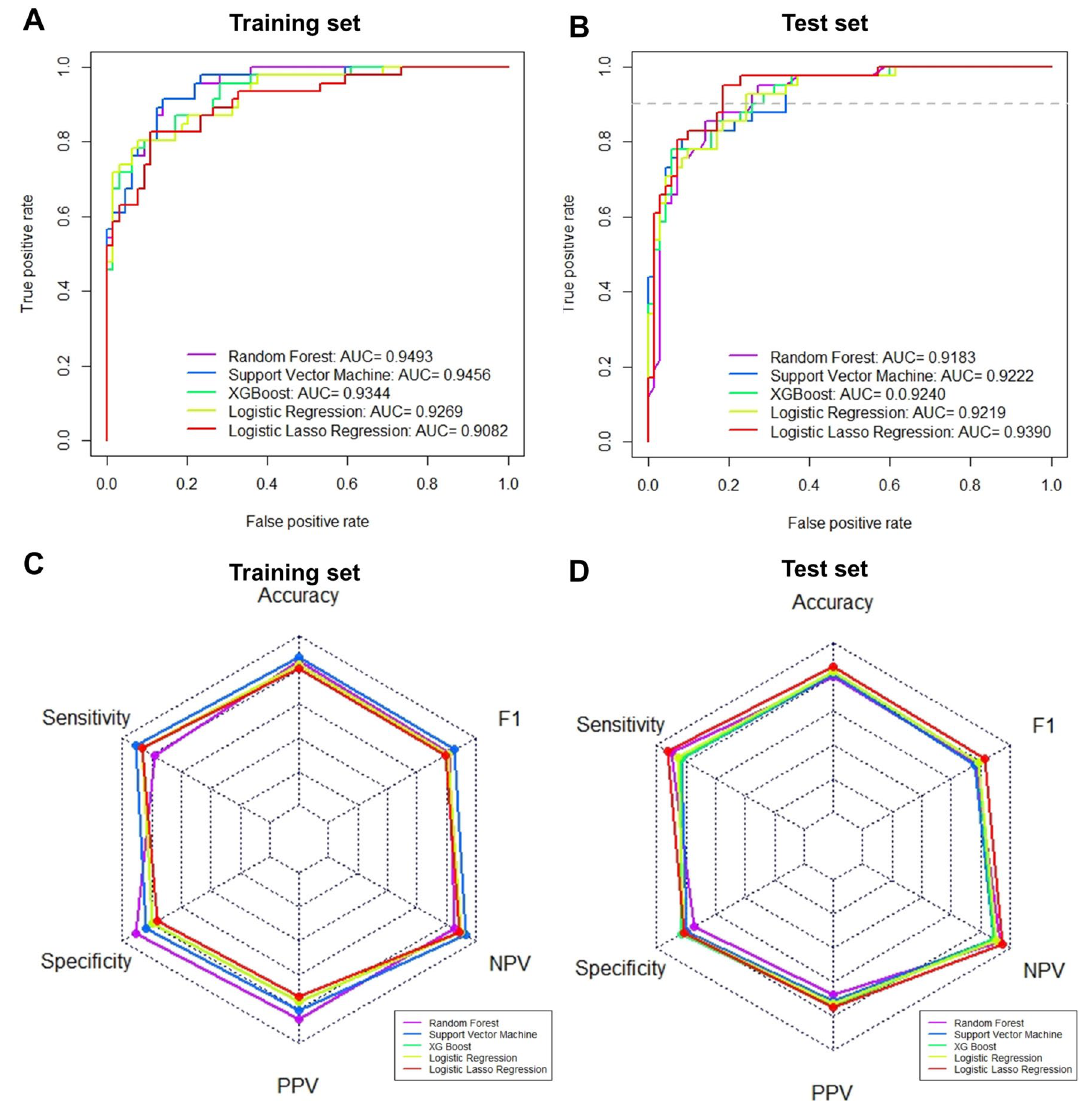
Figure 2. Receiver operating characteristic curve (ROC) and radar plot showing the performance of five different prediction models. ( A ) ROC curve for the training set. ( B ) ROC curve for the test set. ( C ) Radar plot for the training set. ( D ) Radar plot for the test set. AUC, area under the curve; NPV, negative predictive value; PPV, positive predictive